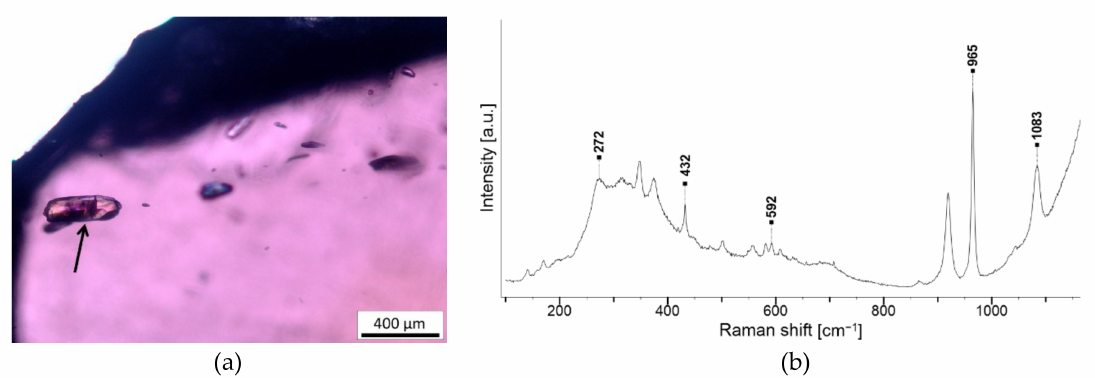
Figure 8. Inclusions in garnet G3 of fibula NA401. ( a ) Idiomorphic apatite inclusion. Reflected light, parallel polars; ( b ) Raman spectrum of apatite in almandine